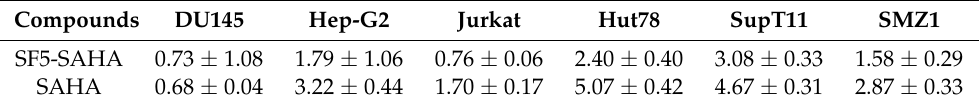
Table 1. Growth inhibitory activity expressed as IC 50 ( µ M) of test compound SF5-SAHA and of SAHA as positive control in human prostate (DU145) and hepatoma (Hep-G2) cancer cells as well as in human T-cell leukemia/lymphoma cell lines (Jurkat, Hut78, SupT11, SMZ1), as determined after 48 h. SAHA was used as clinically relevant reference for single HDAC-inhibition. All results are described as means ± SEM of n ≥ 3 independent experiments. Compounds DU145 Hep-G2 Jurkat Hut78 SupT11 SMZ1